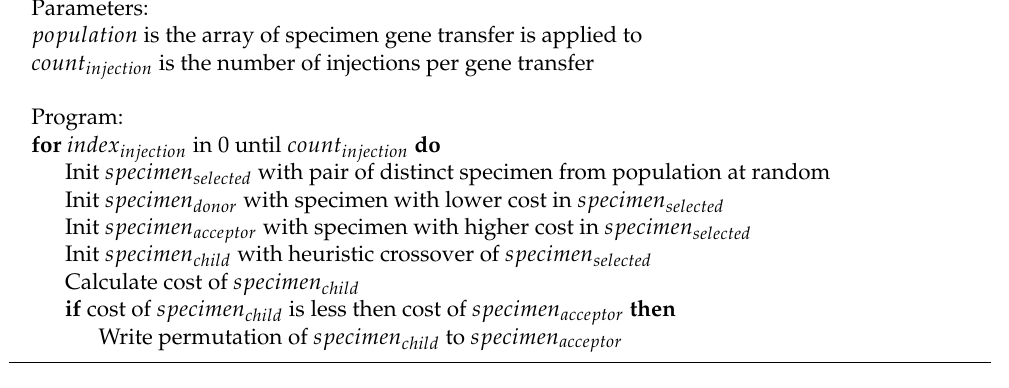
Algorithm 3 Gene transfer with feedbacked half heuristic crossover